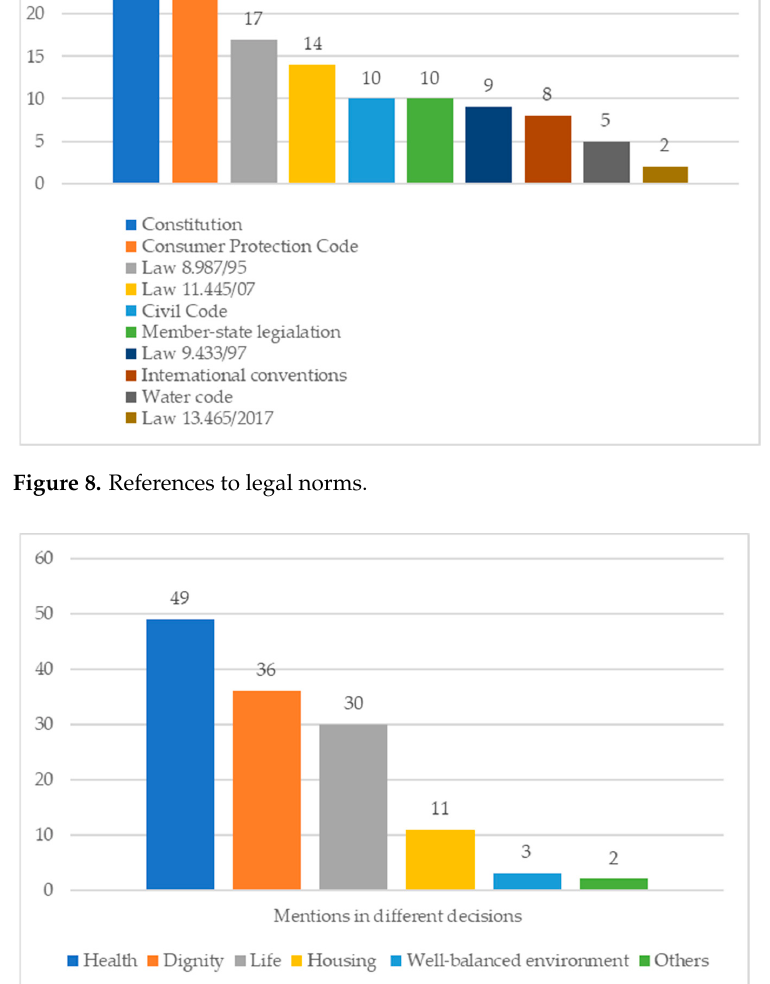
Figure 9. Rights and principles